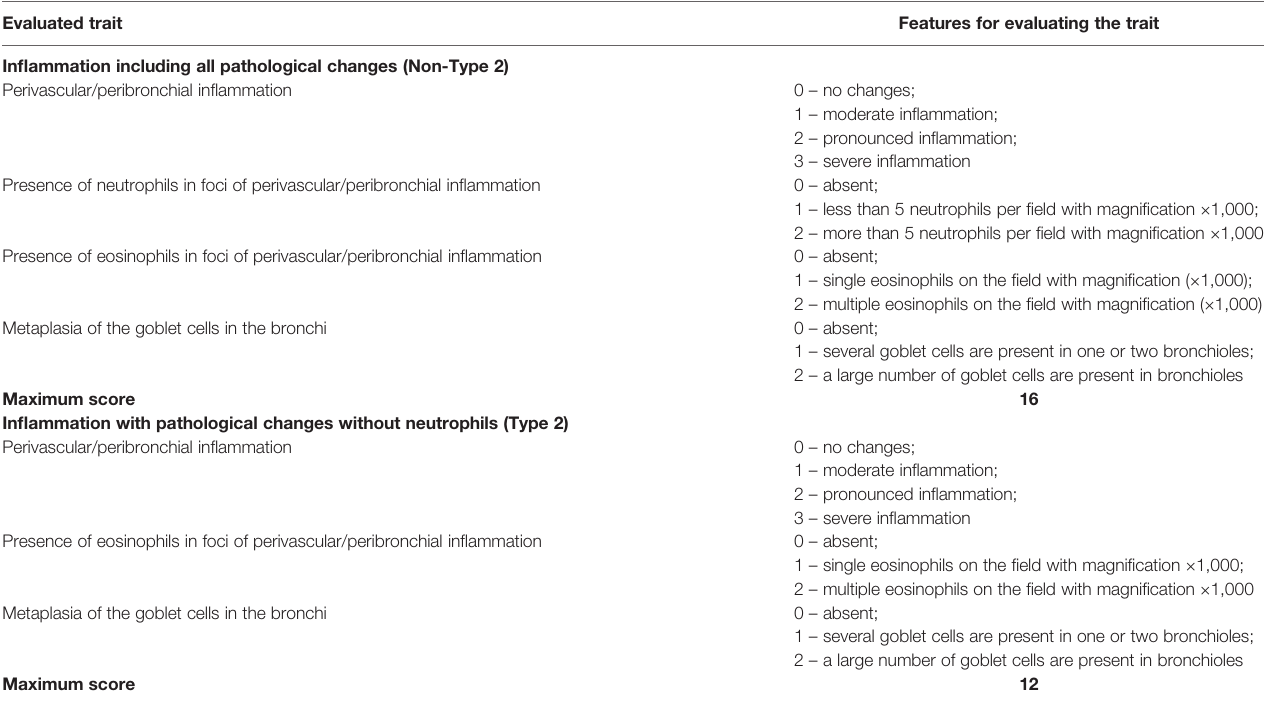
TABLE 2 | Scale for assessing pathological changes in mouse